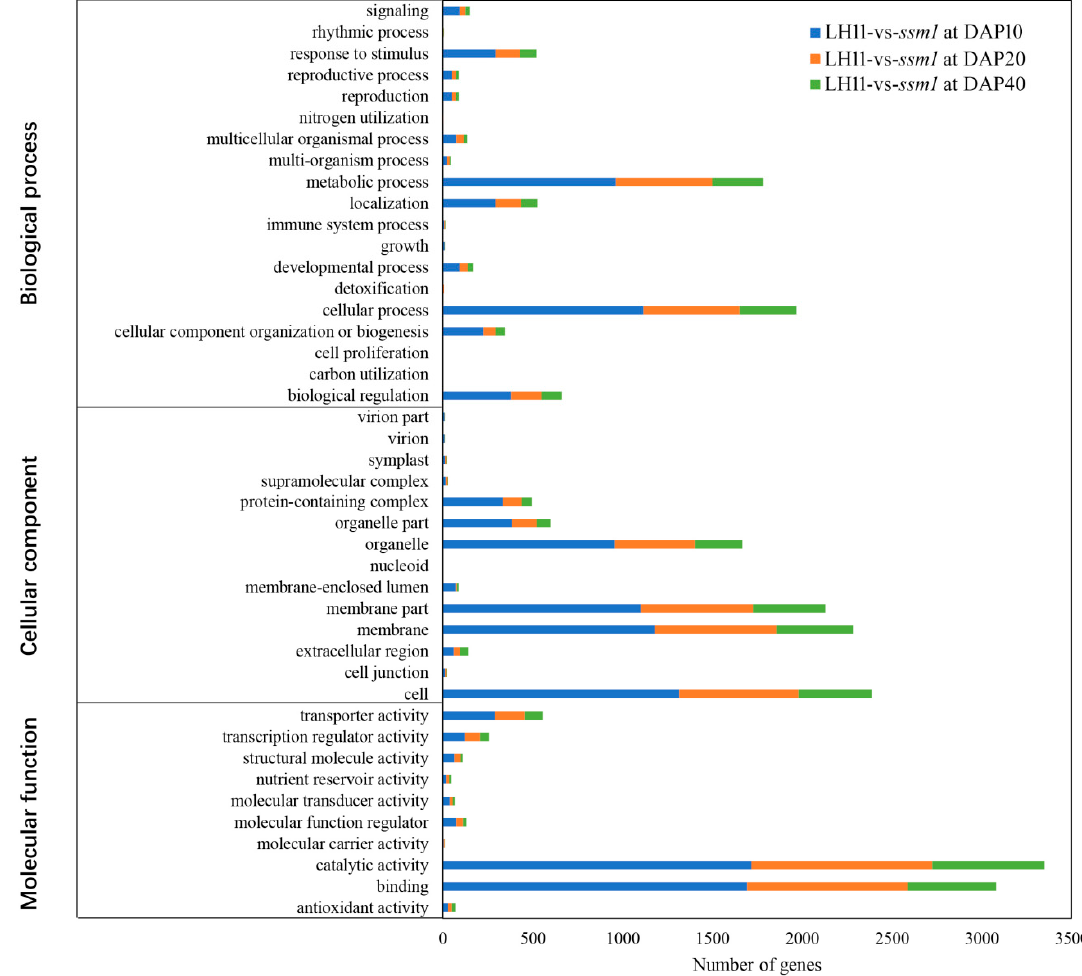
Figure 5. GO classification analysis of DEGs in seeds of ssm1 and LH11. The X -axis represents the number of genes annotated into the GO terms, and the Y -axis represents the functional classification of